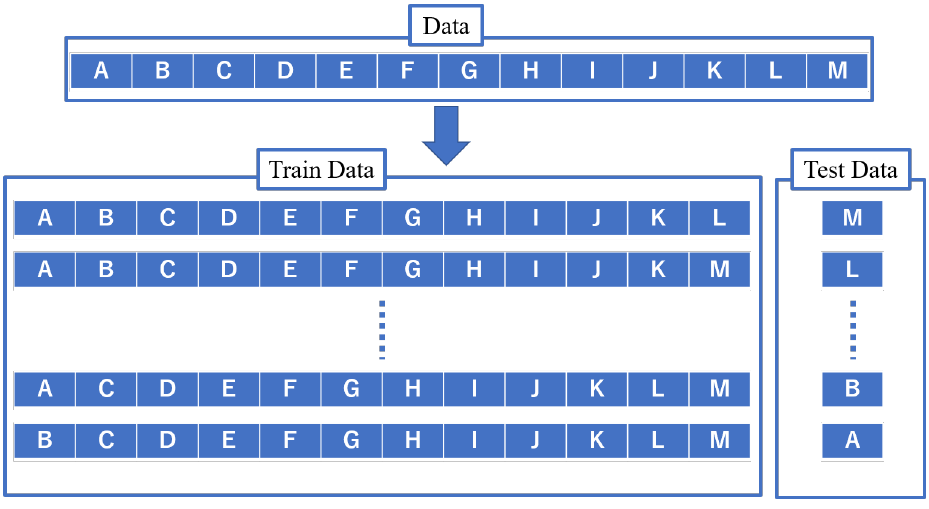
Figure 4. Behavior change stage estimation